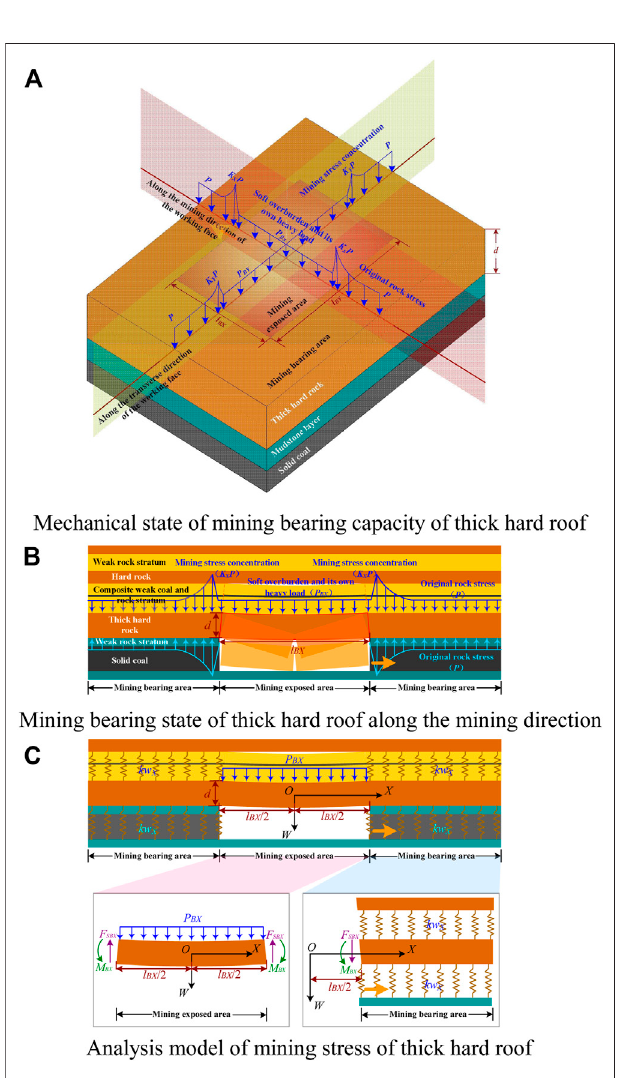
FIGURE3| Schematic diagramoftheminingbearingmechanicalmodel of the thick hard roof. (A) Mechanical state of the mining bearing capacity of the thick hard roof. (B) Mining bearing state of the thick hard roof along the mining direction. (C) Analysis model of mining stress of the thick hard